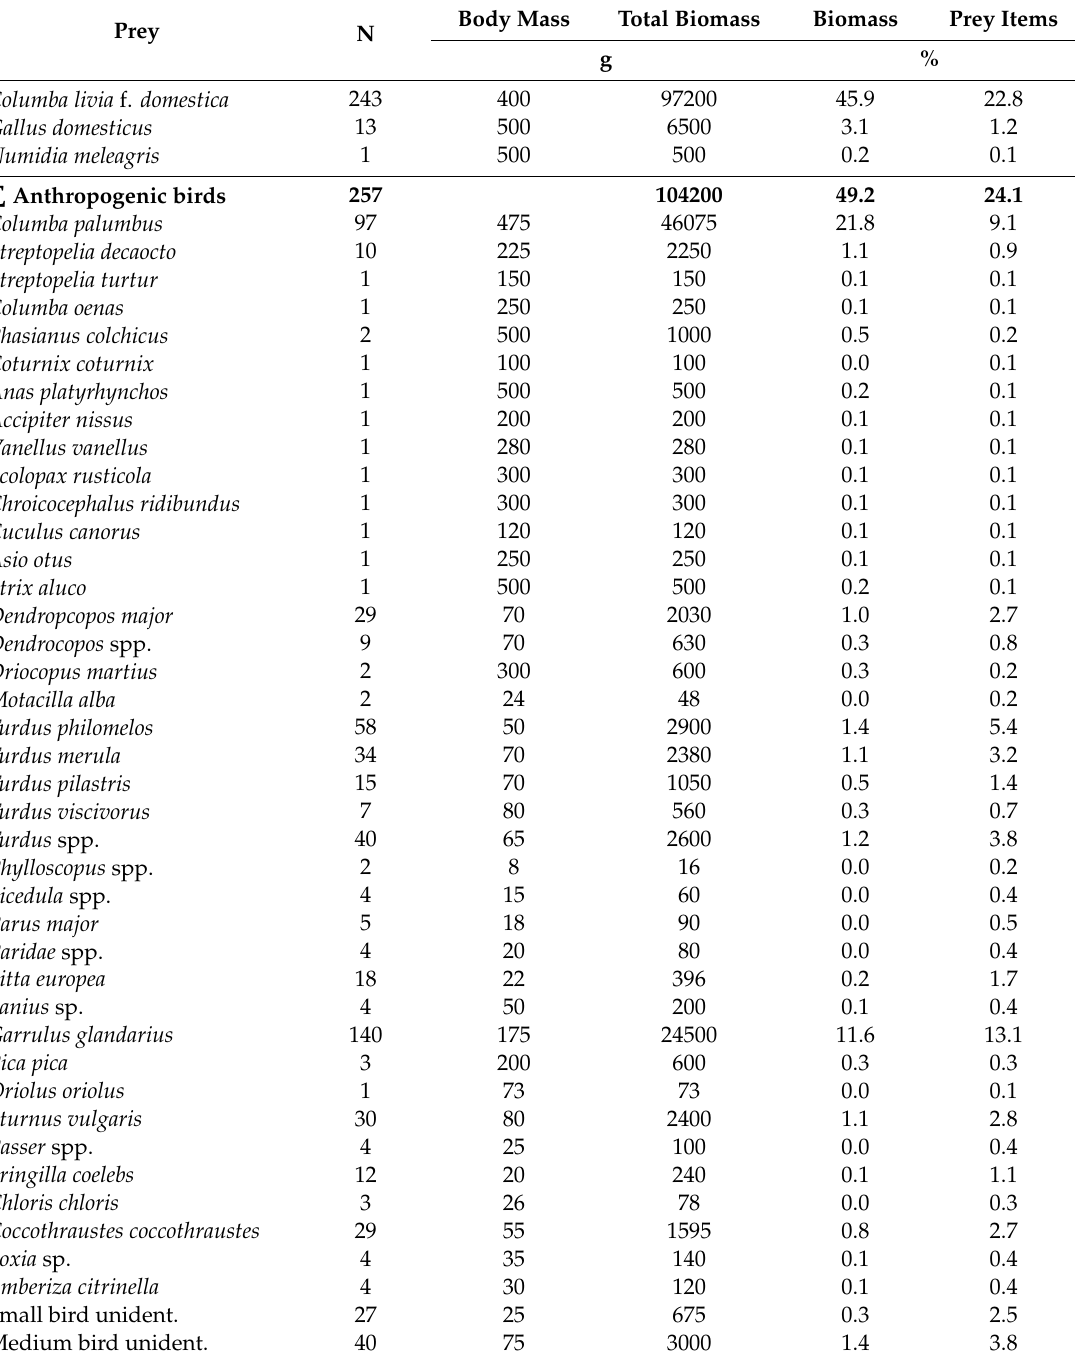
Table A1. A detailed diet composition of the goshawks in the area of study (central Poland, vicinity of Rog ó w village, Experimental Forest Station of Warsaw University of Life Sciences) in the years 2011–2018 based on an analysis of the remains from the plucking sites and